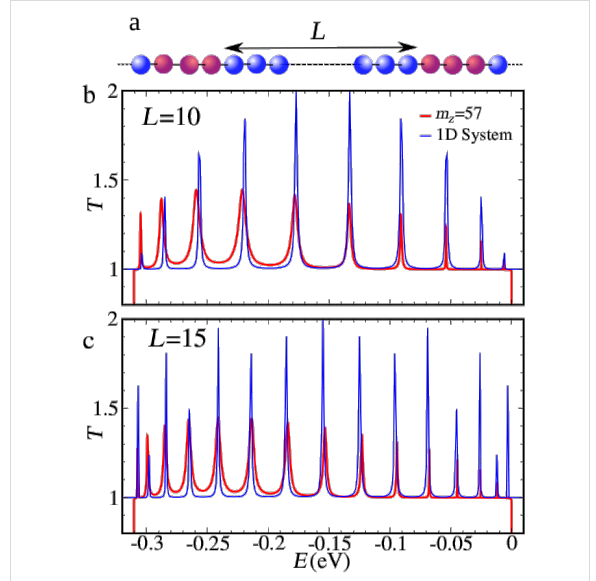
Figure 5: Comparison between the transmission probabilities at the central band-energy ranges for shallow constrictions, m Z = 57, and equivalent s-like orbitals chain toy model. (a) Representation of the one 1D double-barrier quantum well structure at the upper edge. The central blue sites represent the quantum well at the constriction, while the red ones are for the barriers (armchair steps). The left and right contacts at the upper edges are also represented by blue sites. (b) Transmission probabilities for the constriction L = 10: 4-band tight binding model (red) and the toy model (blue). (c) The same as (b) but for a longer constriction, L = 15.